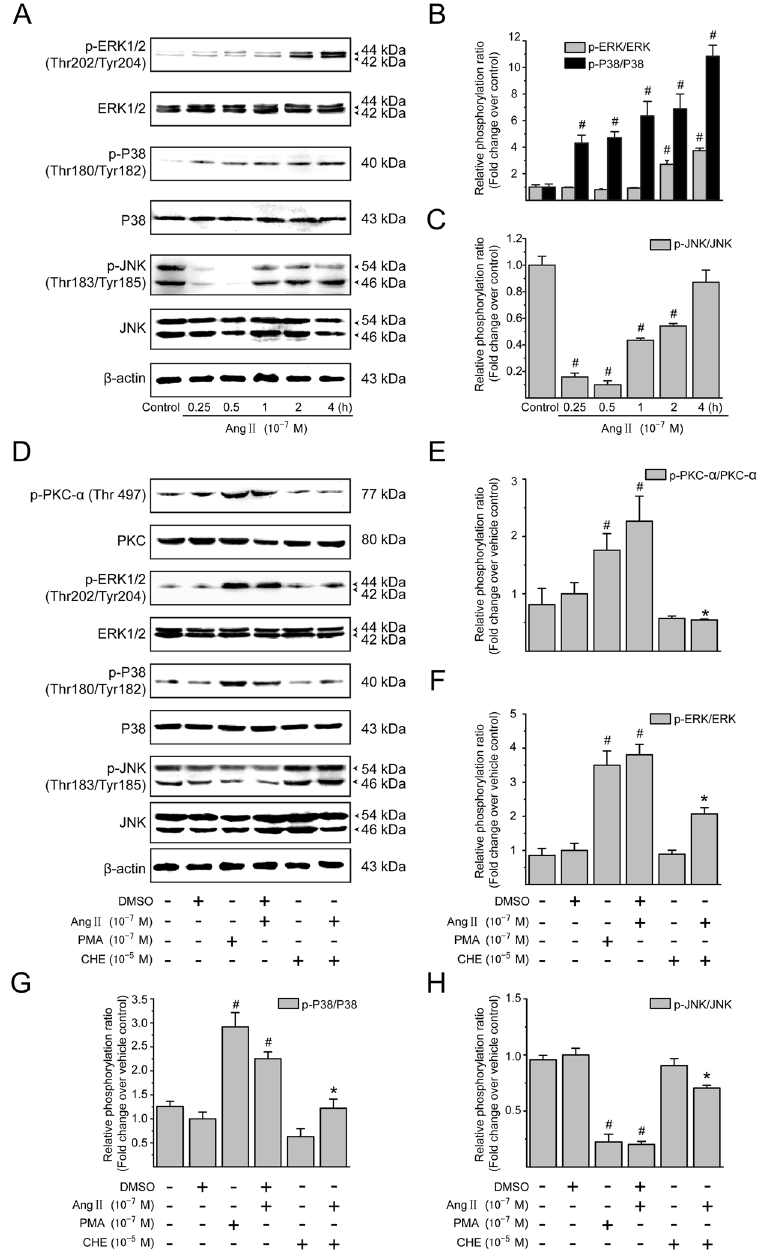
Figure 4. Ang II-mediated MAPK pathways depend on PKC activation in the LX-2 cells. ( A ) Serum- starved LX-2 cells were incubated with Ang II (10 − 7 M) for 0, 0.25, 0.5, 1, 2 and 4 h. Whole cell lysates were immunoblotted with antibodies against ERK1/2, p38 MAPK, JNK, and their phosphorylated forms, respectively. Total protein levels of ERK1/2, p38 MAPK and JNK were used as internal controls. Similar results were observed in 3 independent experiments, and representative immunoblot bands are shown. ( B,C ) Fold-changes in the relative levels of phosphorylated ERK1/2, p38 MAPK and JNK protein are shown after normalizing with the corresponding loading control. The relative protein level in vehicle-treated cells was set as 1.0. ( D ) Serum-starved LX-2 cells were pretreated with CHE (a PKC inhibitor; 10 − 5 M) for 0.5 h, and then incubated with or without Ang II (10 − 7 M) for either 0.5 h (to detect phosphorylated PKC- α , p38 MAPK and JNK) or 2 h (to detect phosphorylated ERK1/2), followed by Western blotting with the indicated antibodies. PMA (10 − 7 M) was included as a positive control. Total protein levels of PKC- α , ERK1/2, p38 MAPK and JNK were used as loading controls. Similar results were observed in 3 independent experiments, and representative immunoblots for each protein are shown. ( E–H ) The protein levels of phosphorylated forms of PKC- α , ERK1/2, p38 MAPK and JNK were normalized with the value of respective loading control. It was designated as relative phosphorylation ratio compared with that in vehicle-treated cells (defined as 1-fold). Results are presented as mean ± SD of 3 independent experiments. # P < 0.05 versus unstimulated or vehicle-treated control cells; * P < 0.05 versus Ang II-treated